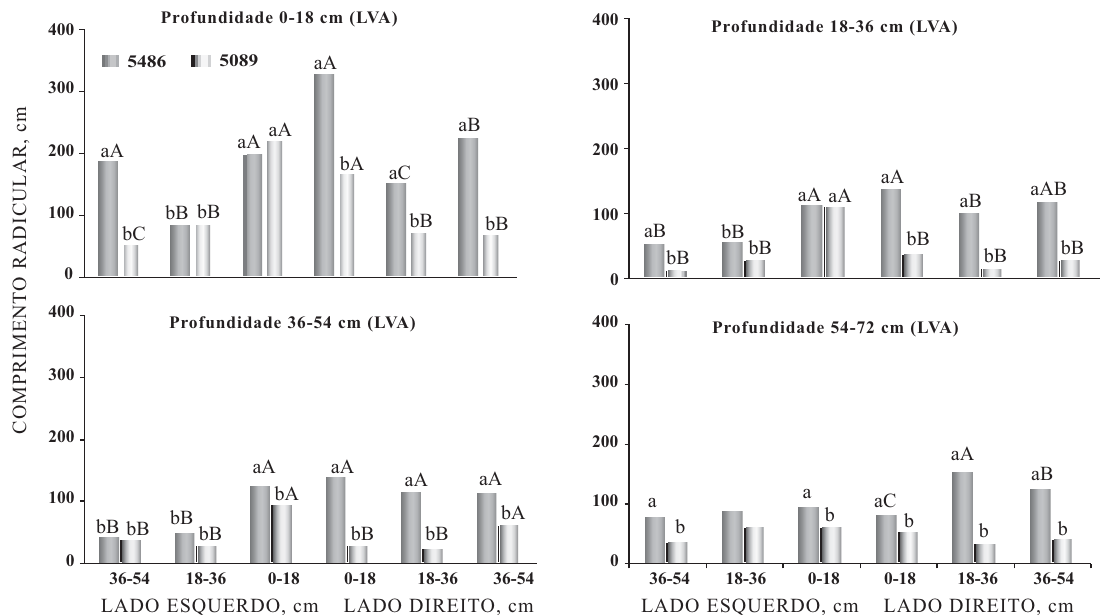
Figura 5. Comprimento radicular nos lados esquerdo e direito das linhas de cana-de-açúcar em quatro profundidades no LVA. Letras minúsculas comparam cultivares dentro de cada distância horizontal. Letras maiúsculas comparam cada cultivar em relação às três distâncias horizontais. Diferença mínima significativa (DMS) a 5